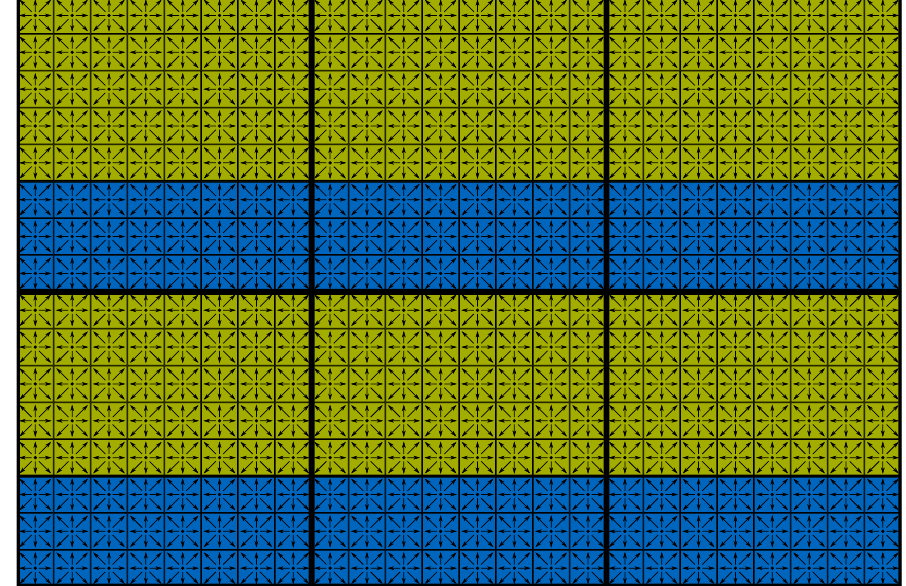
Figure 4. Decomposition of a 2D domain consisting of 24 × 16 lattice cells in 3 × 2 subdomains [19]. Each 8 × 8 subdomain is subdivided in a 8 × 5 upper part assigned to a GPU (green) and a 8 × 3 lower part assigned to a CPU